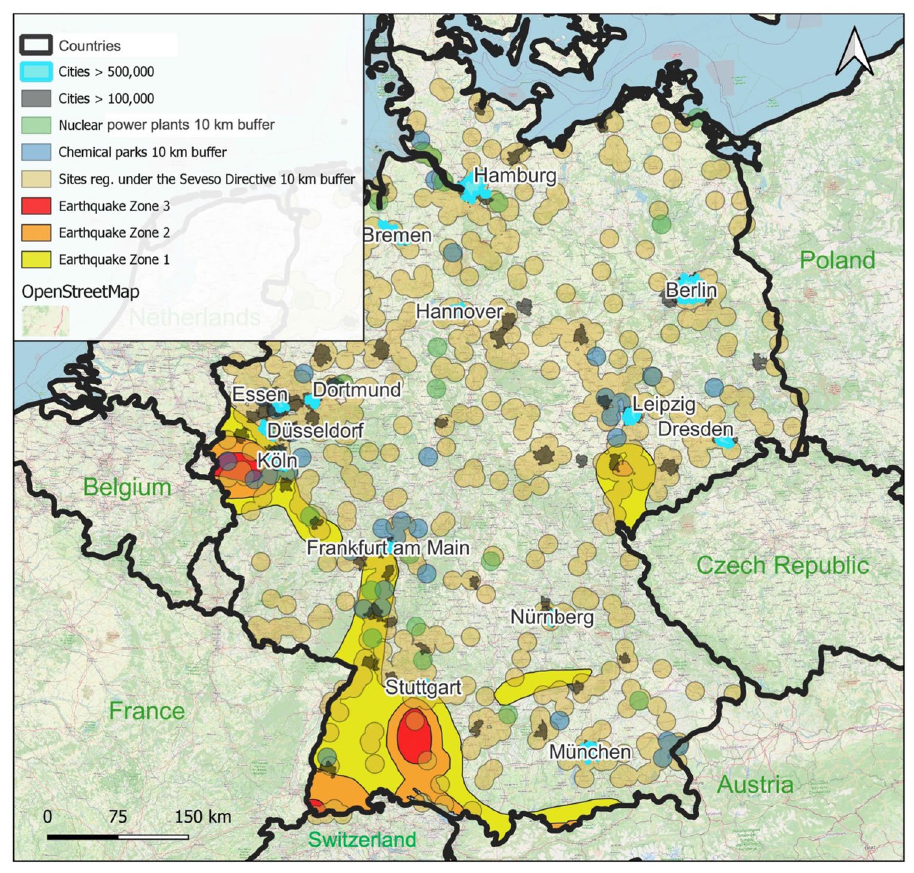
Fig. 5 Earthquake zones in Ger- many and the location of buffer zones of potentially hazardous